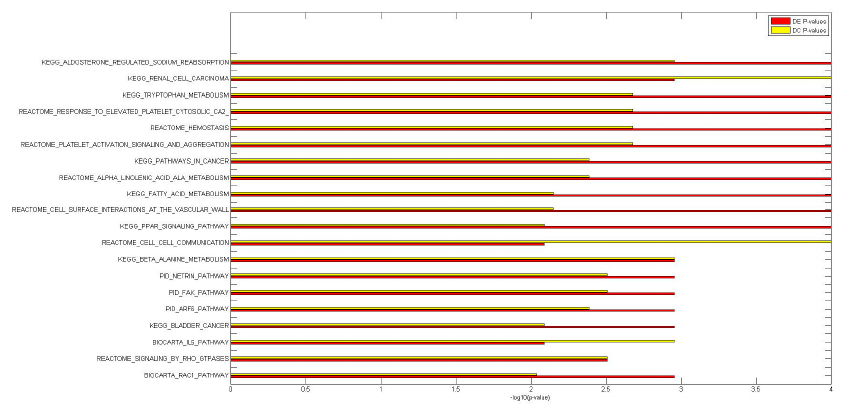
Figure 5. Histogram of differentially expressed (DE) and differentially co-expressed (DC) − log10 p - value plots for the top 20 DC and DE canonical pathways.